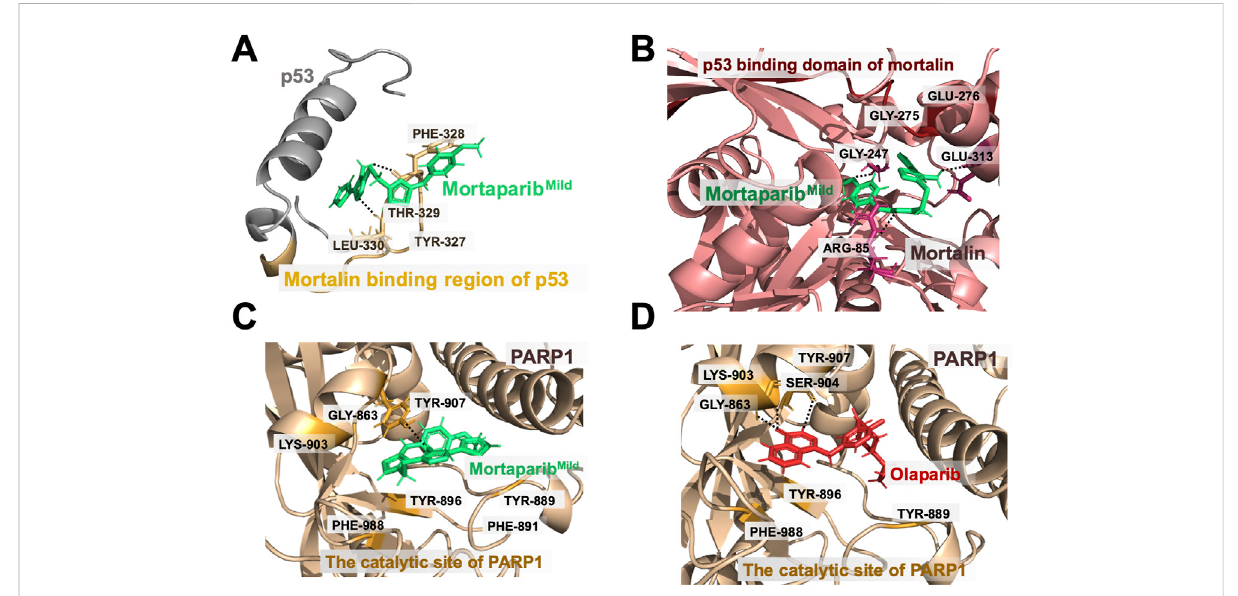
FIGURE 2 Binding interactions ofMortaparib Mild withtargetproteins. (A) Mortaparib Mild interaction atthemortalin-binding region ofp53. (B) Mortaparib Mild interaction at the p53-binding region of mortalin. (C) Mortaparib Mild interaction with the catalytic domain of PARP1. (D) Olaparib interaction with the catalytic domain of